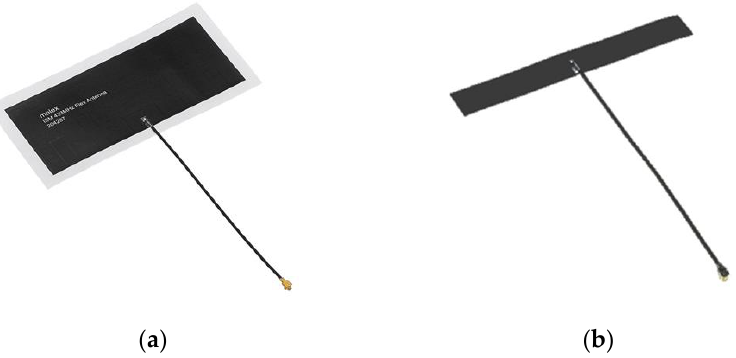
Figure 5. Antennas used for evaluating 433 MHz and 915 MHz ISM bands, with ( a ) ISM 433 MHz Flex Antenna and ( b ) ISM 868/915 MHz